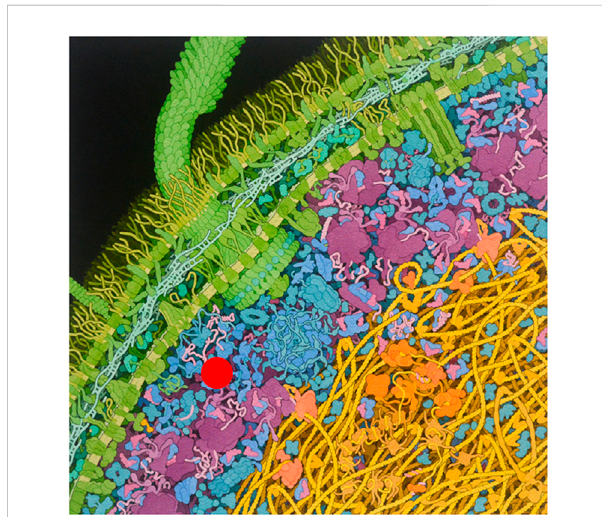
FIGURE 1 Cartoon of the crowded interior of an Escherichia coli cell. The testproteinmolecule(red)isinthecytoplasmexteriortothenucleoid, consisting of primarily soluble proteins, ribonucleic acids, and macromolecular assemblies such as ribosomes and proteasomes. Nonspeci fi c interactions between the test protein and their immediate surroundings within a medium as heterogeneous and highly volume occupied as the bacterial cytoplasm can signi fi cantly in fl uence the equilibria and rates of reactions (i.e., self- and hetero- associations) in which the test protein participates. Figure from Goodsell